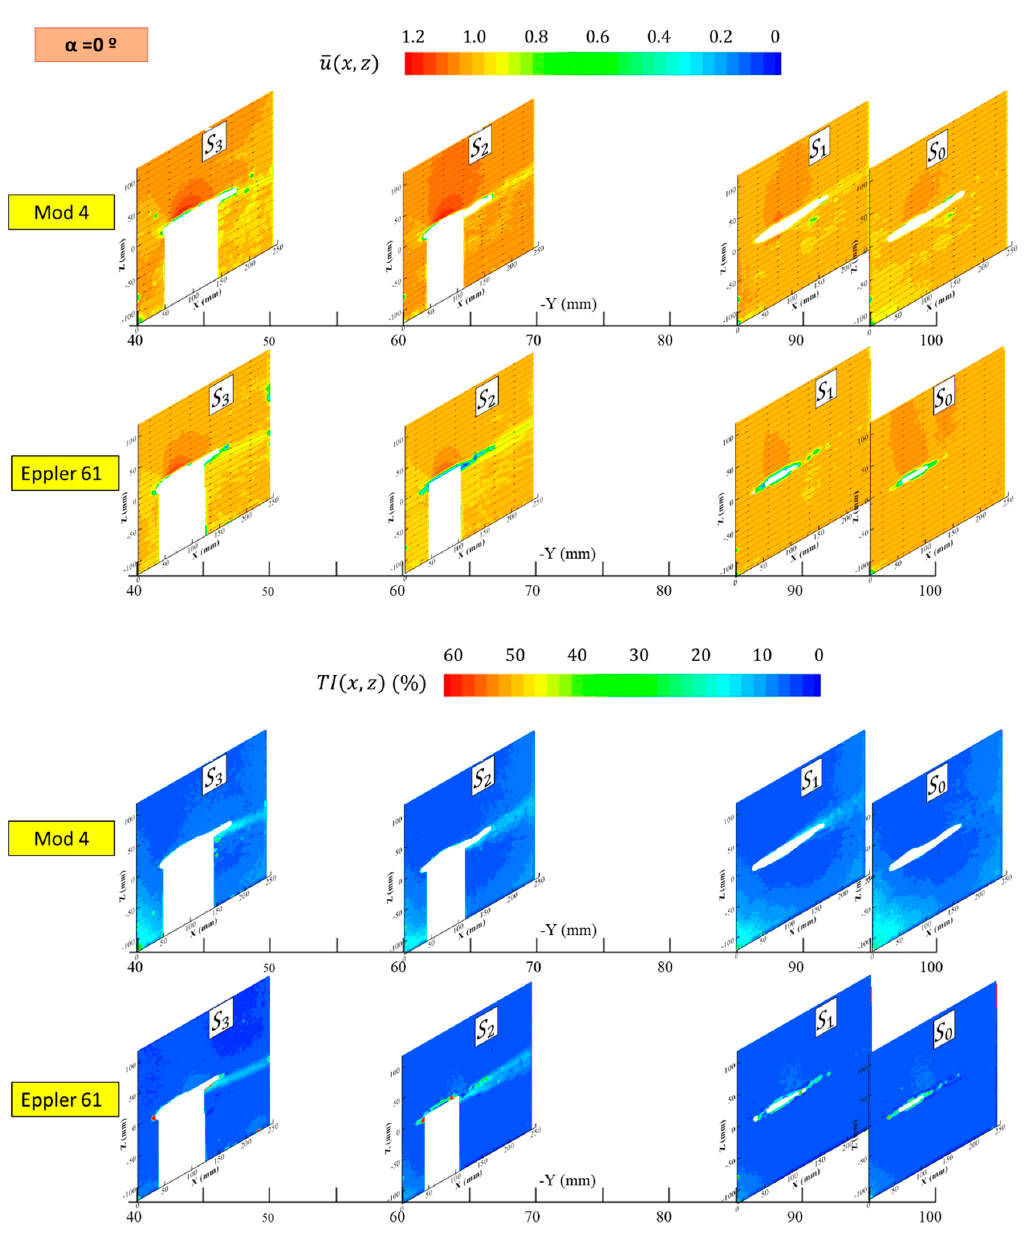
Figure 8. Non-dimensional velocity maps and turbulence intensity maps for each section at an angle of attack of 0°.